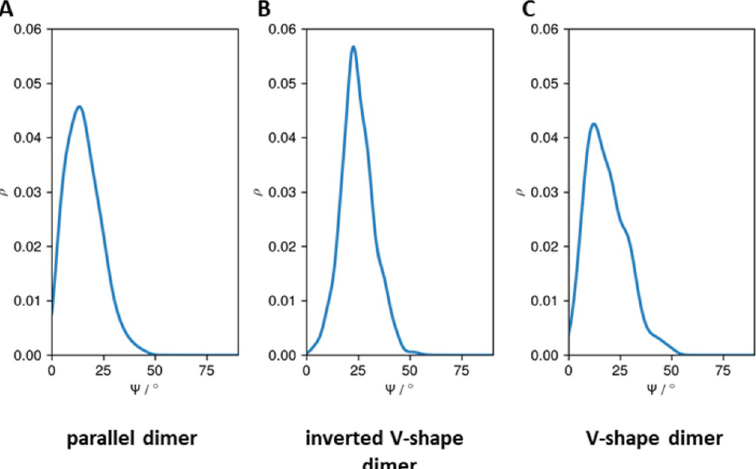
Fig 6. The distributions of the crossing angles ( C ) between the helices forming the homodimer in each dimer topology: A) parallel dimer, B) inverted V-shape dimer, and C) V-shape dimer.